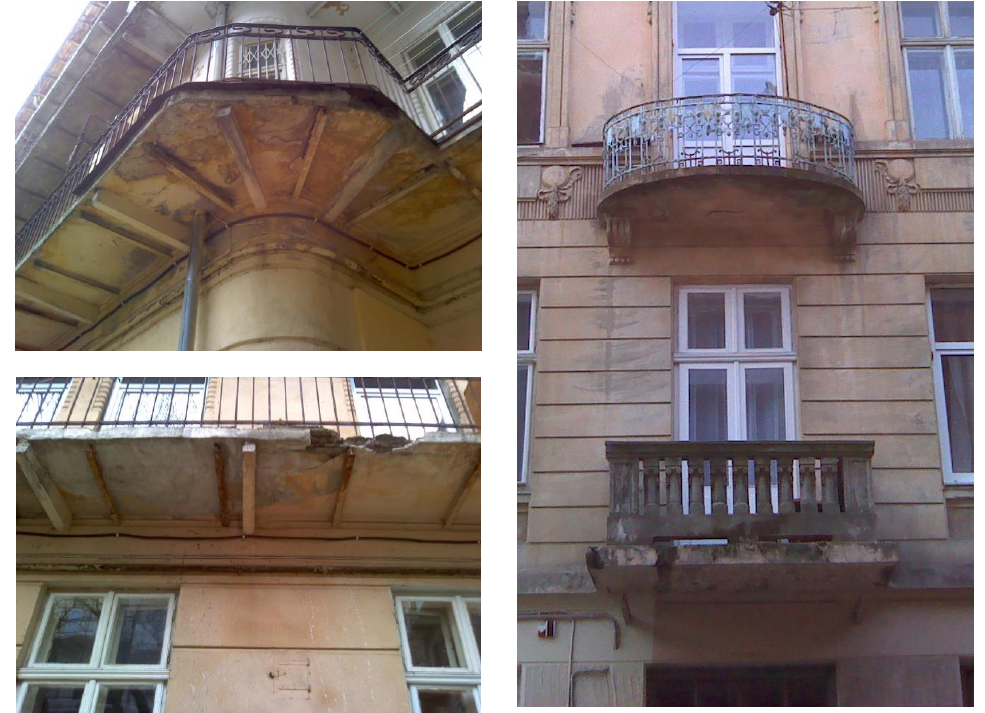
Figure 4. Structural system of the building’s balcony slabs. Visible corrosion of slab elements and steel beams.